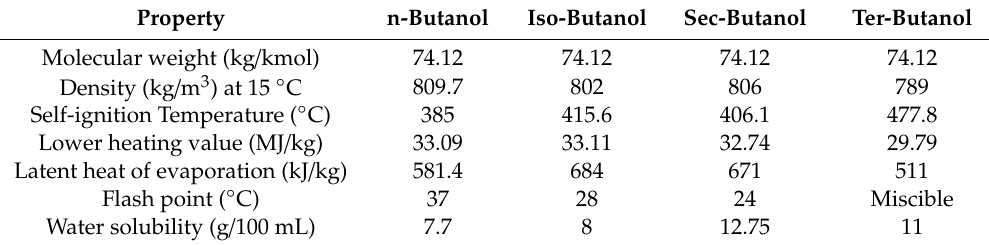
Table 2. Properties of butanol isomers